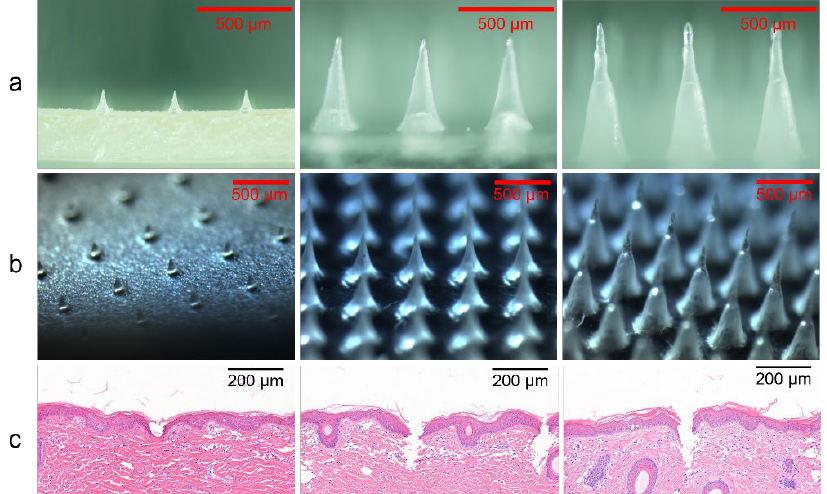
Figure 1. Images of needles morphology ( a ), arrays ( b ), and intradermal penetration depth ( c ) of DMNs with needle heights of 230 μm, 500 μm, and 700 μm, obtained by fluorescence microscope, stereo microscope, and tissue slices, respectively.